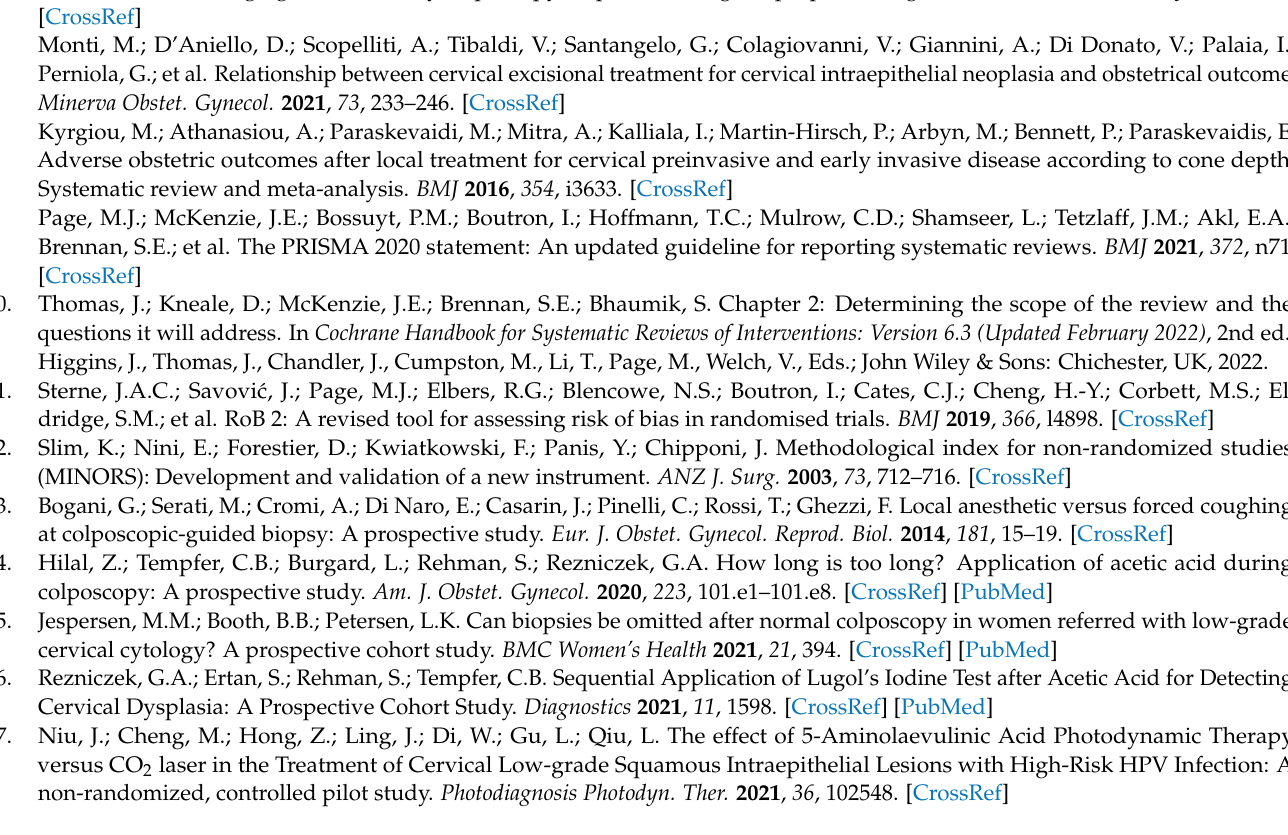
Abbreviations ASCUS, atypical squamous cells of undetermined significance; C-LETZ, contour-loop excision of the transformation zone; CI, confidence interval; CIN, cervical intraepithelial neoplasia; HPV, Human Papilloma Virus; HSIL, high-grade squamous intraepithelial lesions; LEEP, large loop excision of the transformation zone; LLETZ, large loop excision of the transformation zone; LSIL, low-grade squa- mous intraepithelial lesions; MD, mean difference; OR, odds ratio; PCT, non-randomized controlled trial; PICO, Population/Problem-Intervention/Exposure-Comparison-Outcome; PRISMA, Preferred Reporting Items for Systematic Reviews and Meta-Analyses; RCT, randomized controlled trial; RR, relative risk; SWETZ, Straight Wire Excision of the Transformation Zone; TCBEE, True Cone Biopsy Electrode Excision; and US, United